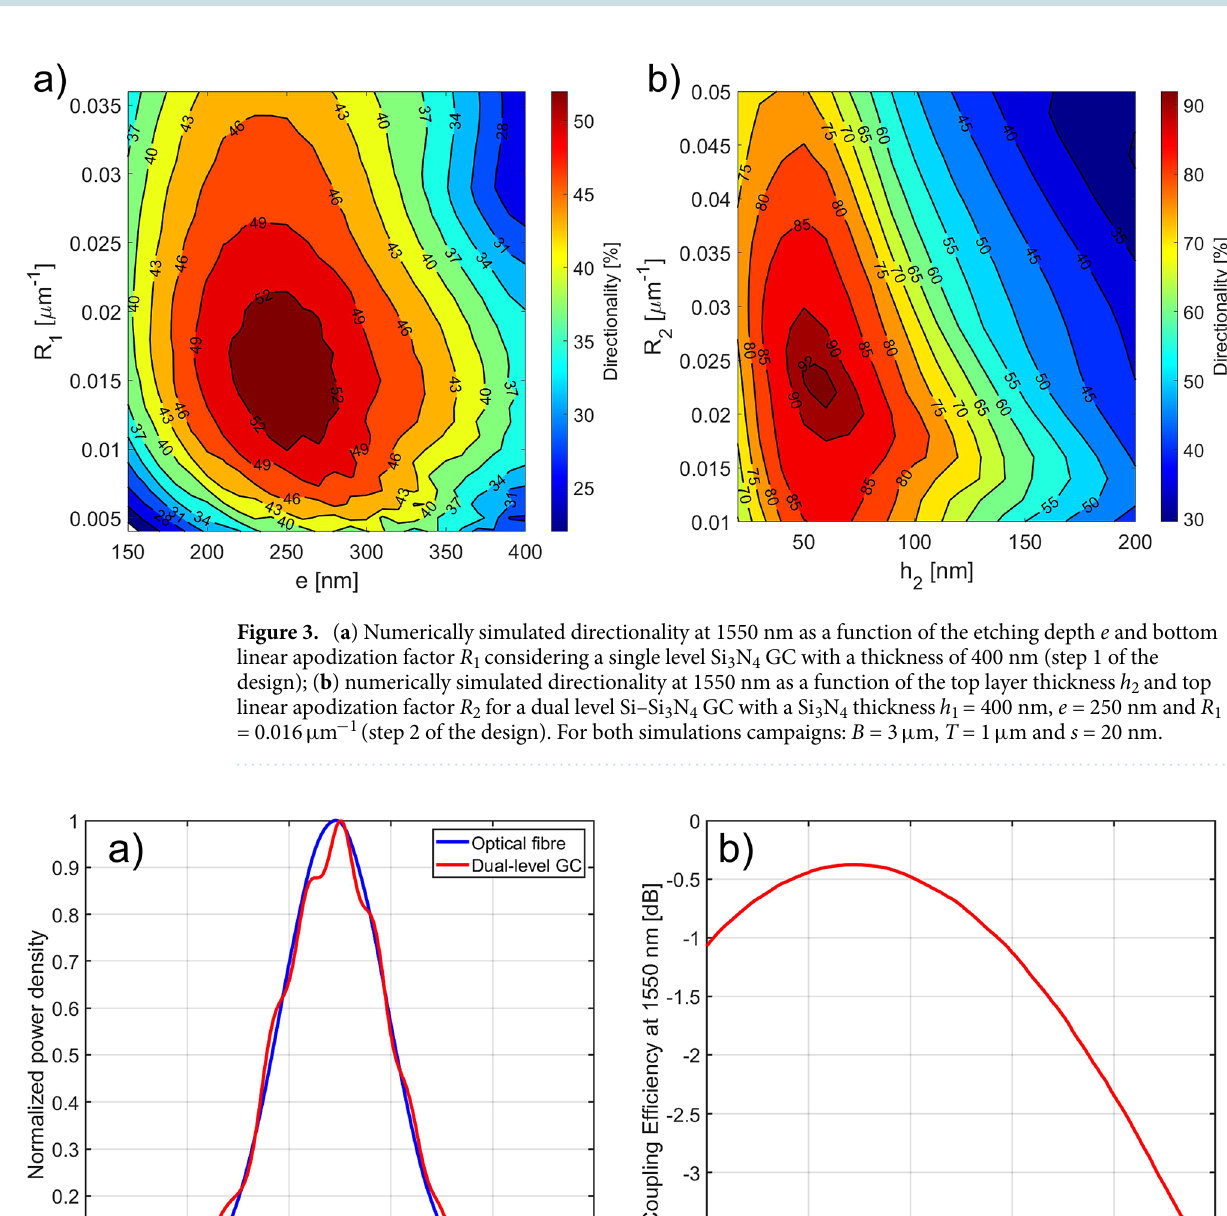
value: for a variation of ± 30 nm around the nominal value of 75 nm, a maximum CE decrease of around 0.14 dB can be observed. If the spacing between the two layers is increased beyond 150 nm, the CE starts to significantly decrease, since the device does not behave any longer like a single GC with a combination of two layers of teeth. The optimization procedure was then repeated considering different fixed fibre coupling angles and the results are shown in Fig. 5b. As can be seen, by selecting a wider angle, it is possible to increase the 1 dB BW of the GC at the expense of a small decrease in CE. For example, by selecting a coupling angle equal to 3 ◦ , a 1 dB BW of 35